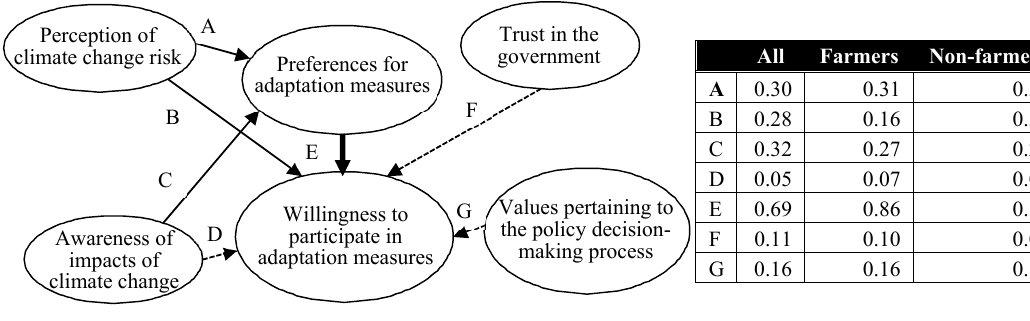
Figure 4. Determinants of the attitudes toward climate change adaptation measures (results estimated using covariance structure